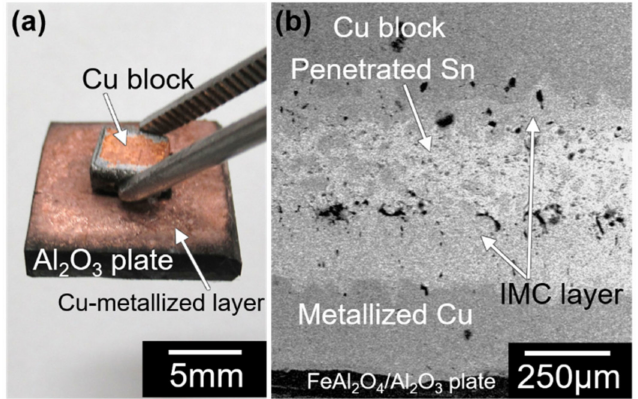
Figure 8. ( a ) Appearance of sample after joining experiment and ( b ) cross-section of the